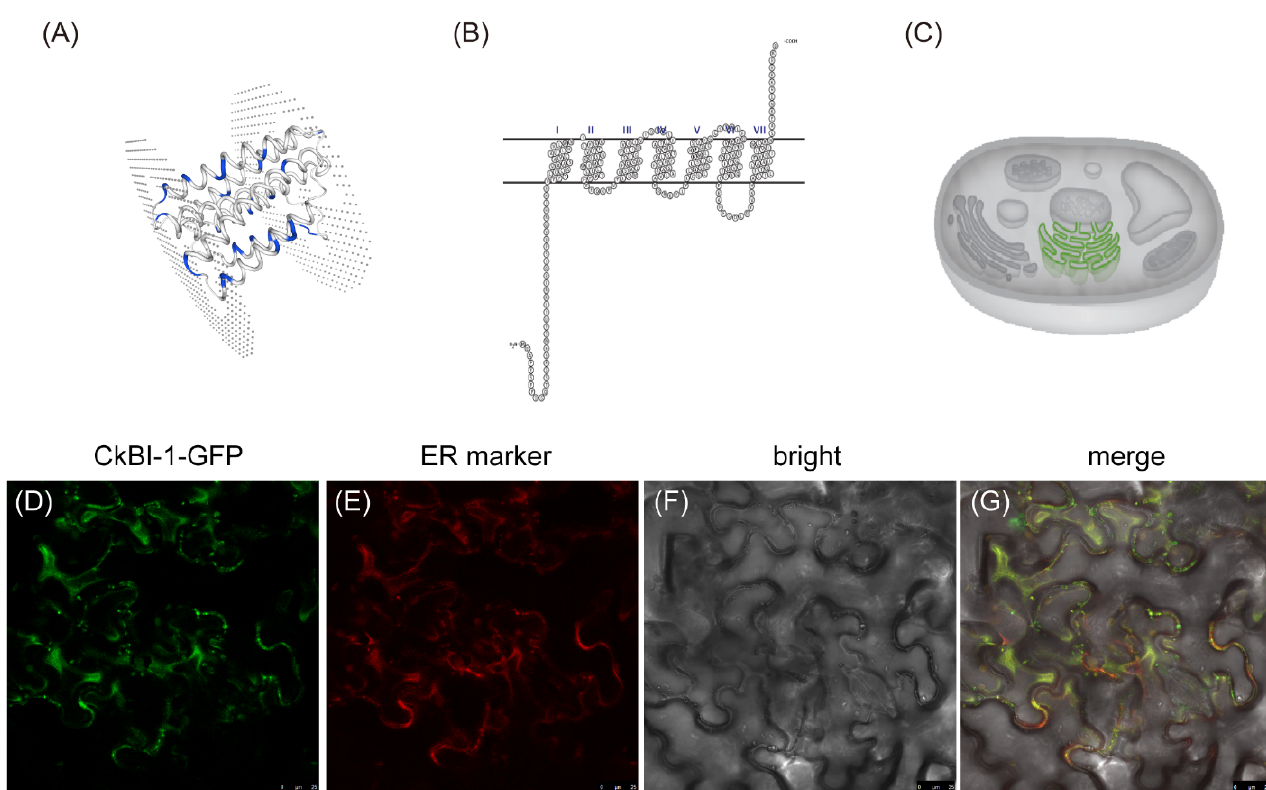
Figure 1. Structural analysis and subcellular localization of CkBI-1 protein. ( A ) Three-dimensional structure of CkBI-1 protein. The two atom layers represent the upper and lower surfaces of the cell membrane. ( B ) Analysis of the transmembrane domain of CkBI-1 protein. ( C ) Prediction of subcellular localization of CkBI-1 protein. ( D – G ) Subcellular localization of CkBI-1 protein. ( D ) GFP excitation wavelength. ( E ) mCherry excitation wavelength. ( F ) Bright field. ( G ) Displayed as an overlay of three channels. Scale bars, 25 μ m.